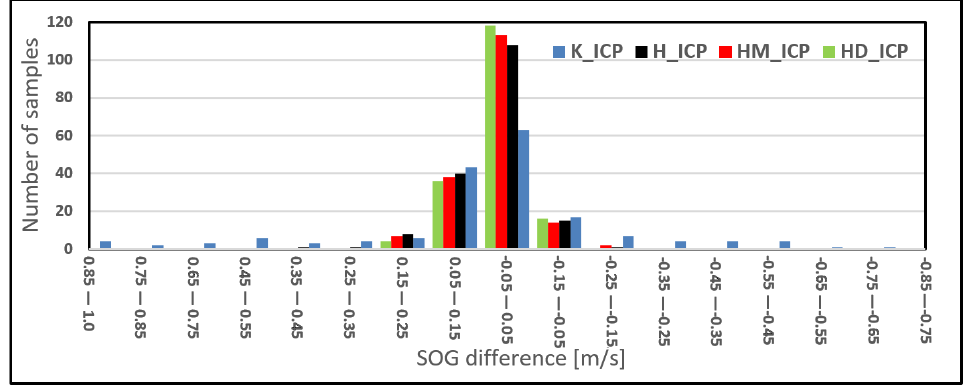
Figure 13. Histogram representing the frequency of occurrence of SOG ICP − SOG R differences.